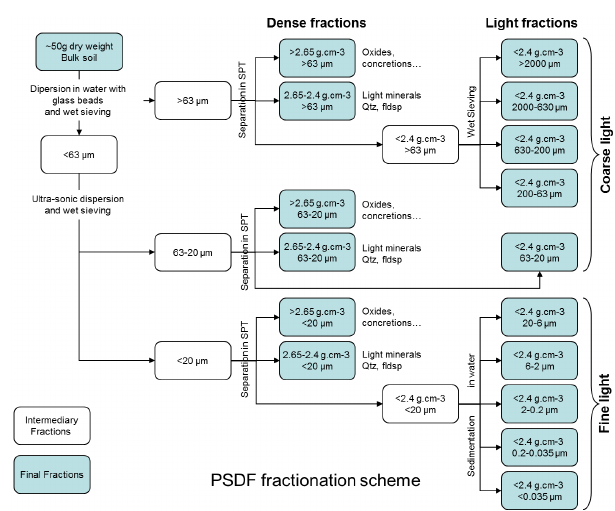
Fig. 8. Suggestion for the improvement of the PSDF fractionation